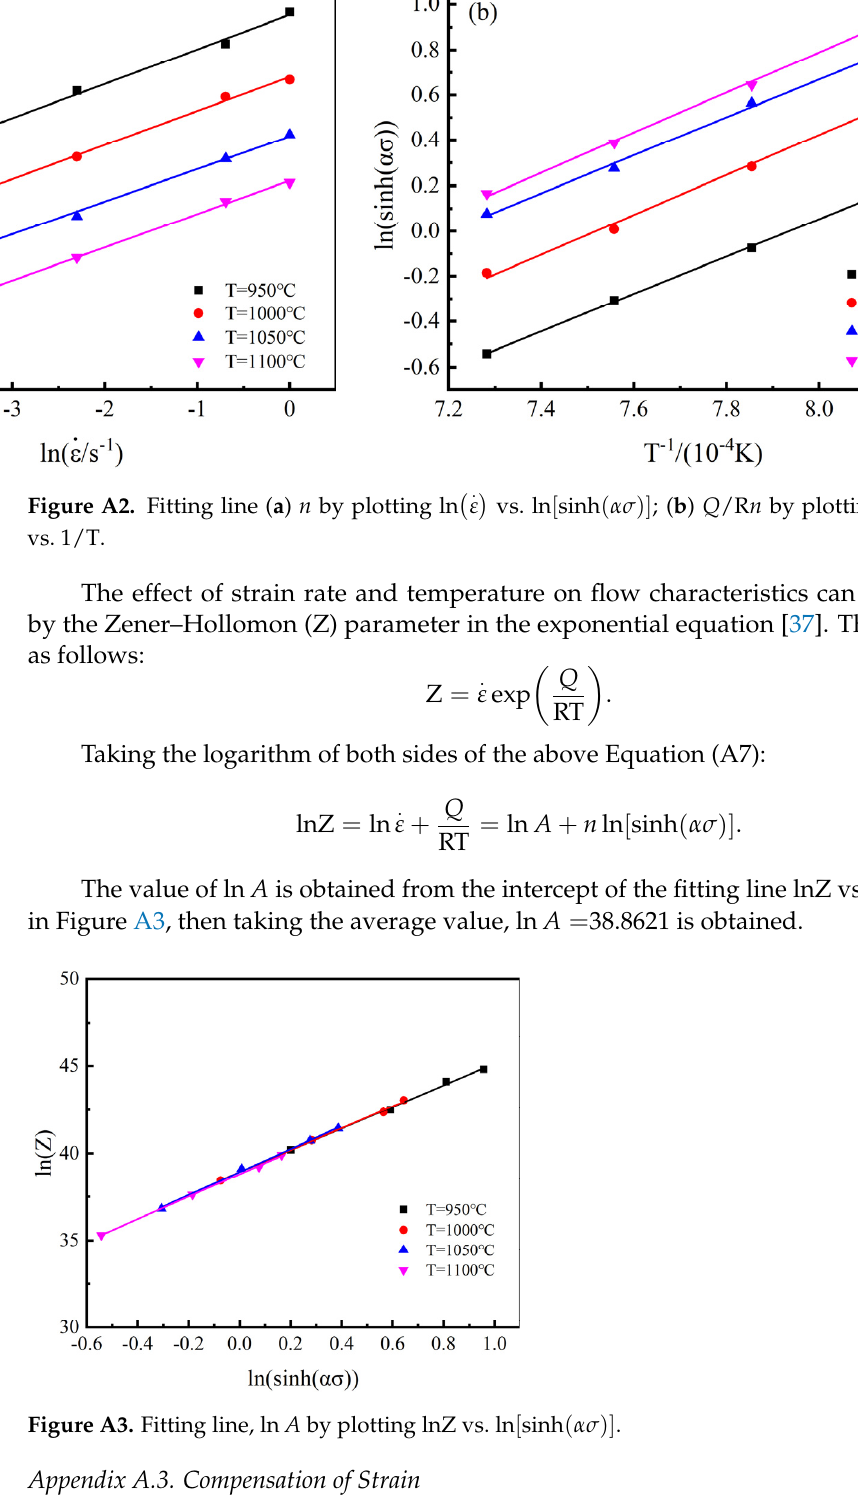
Figure A3. Fitting line, ln𝐴 by plotting lnZ vs. ln(cid:4670)sinh(𝛼𝜎)(cid:4671) .